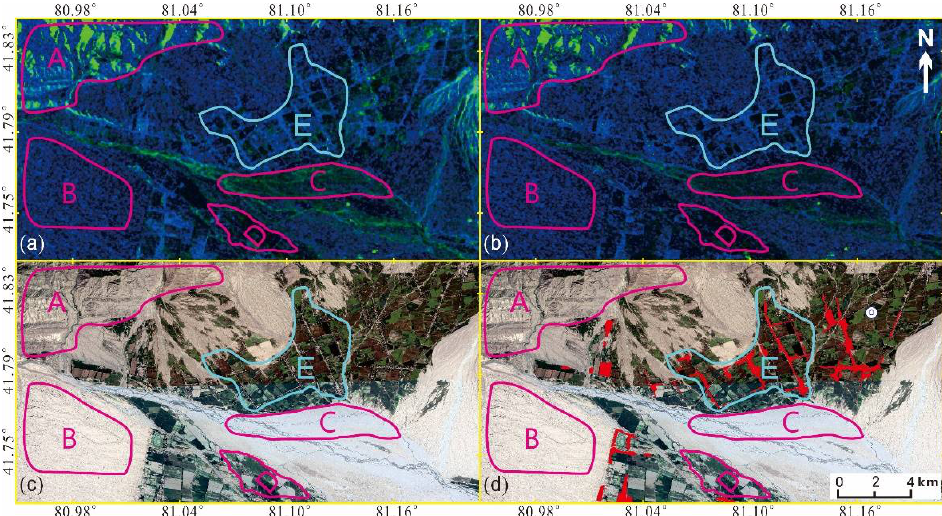
Table 3. Accuracy verification of polarimetric decomposition.